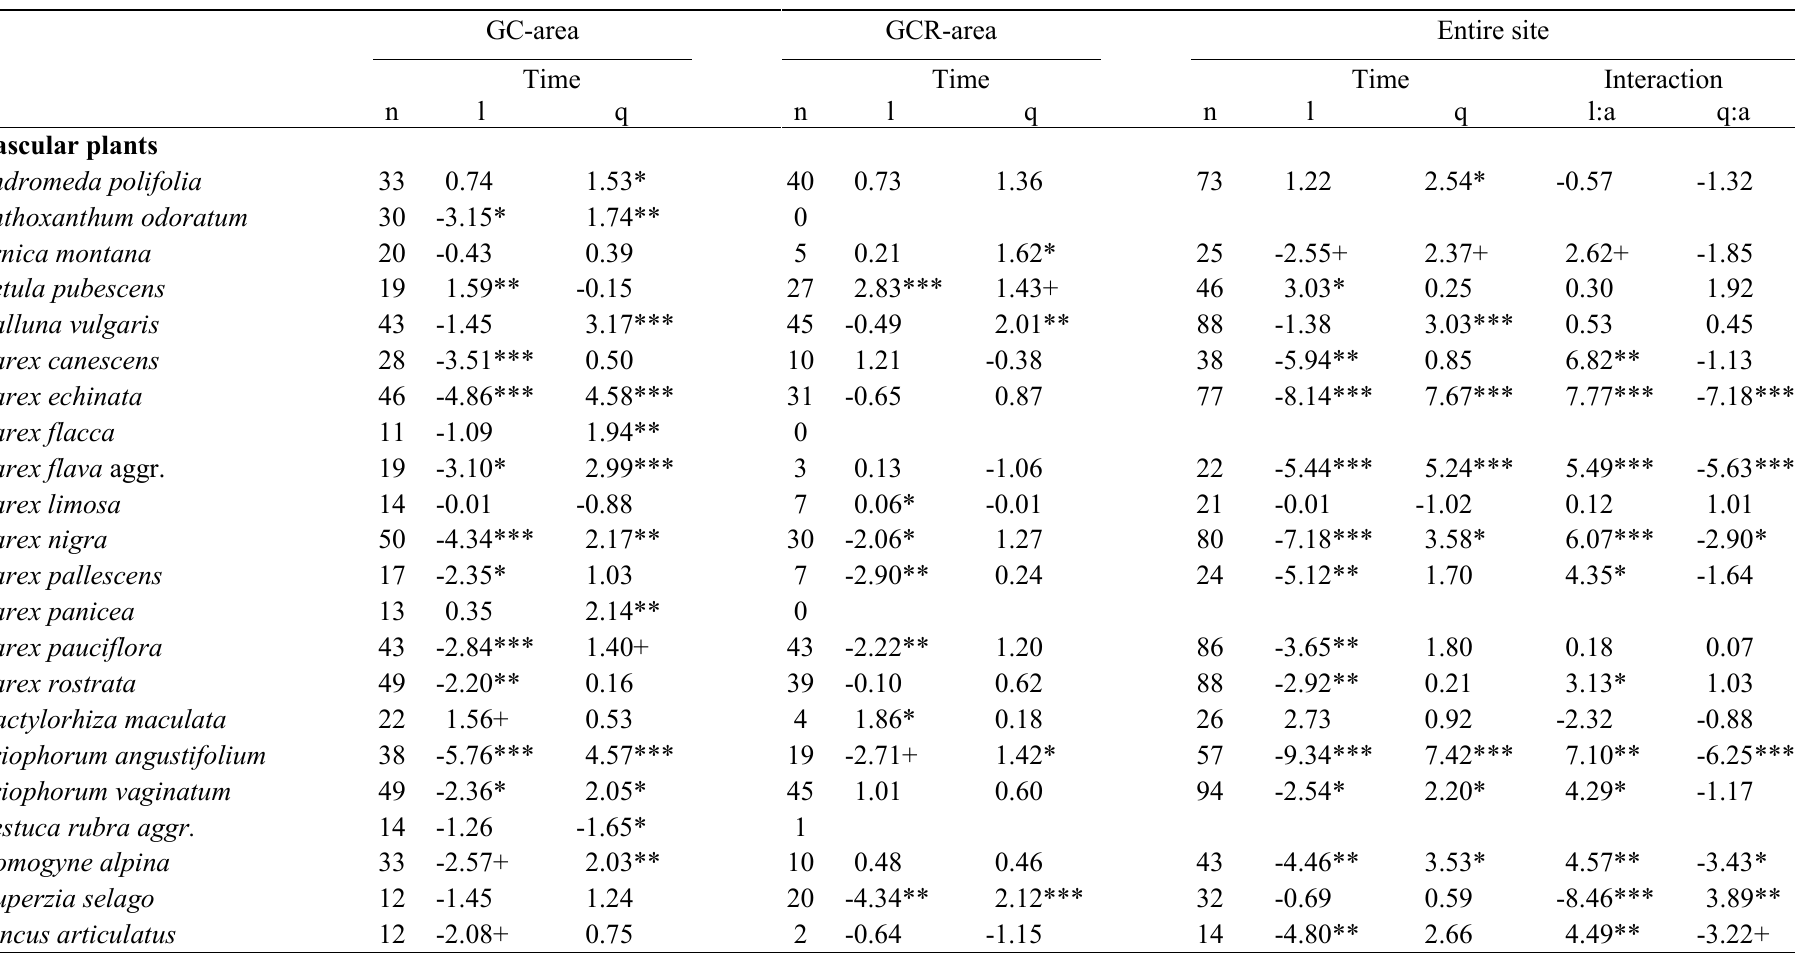
Table A2. Abundance trends in the individual area types (GC and GCR) and the entire site for species occurring in at least 10 plots. Species that were not precisely identified (“sp.” or “cf.”) were not considered. Results of separate regression models for the GC-area and GCR-area, as well as results from the combined model, are shown. Numbers are the effect sizes of the orthogonal polynomials of time and their interaction with area type. GC = grazing cessation; GCR = grazing cessation and rewetting; n = number of plots in which the species was observed at least once; l = linear term; q = quadratic term; l:a = interaction linear term between time and area type; q:a = interaction quadratic term between time and area type. Significance levels: +: p ≤ 0.1; *: p ≤ 0.05; **: p ≤ 0.01; ***: p ≤